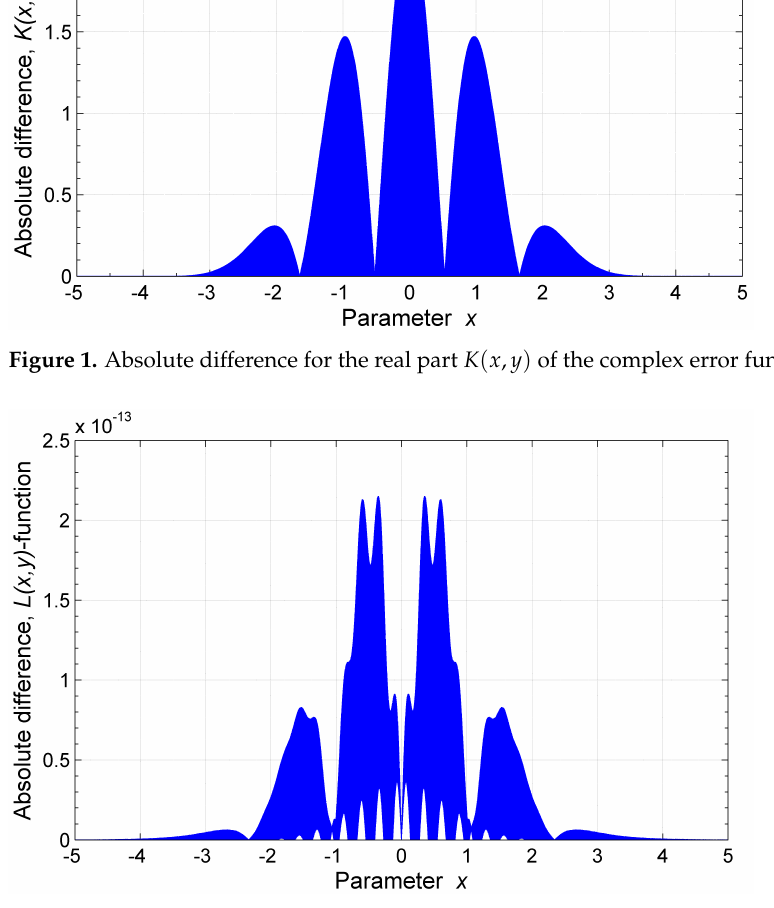
Figure 2. Absolute difference for the imaginary part L ( x , y ) of the complex error